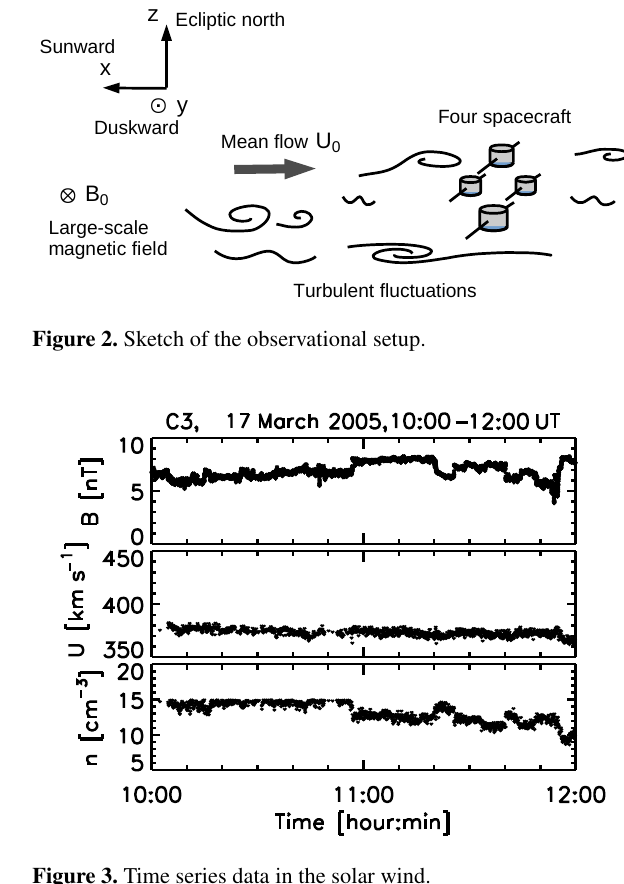
Figure 3. Time series data in the solar